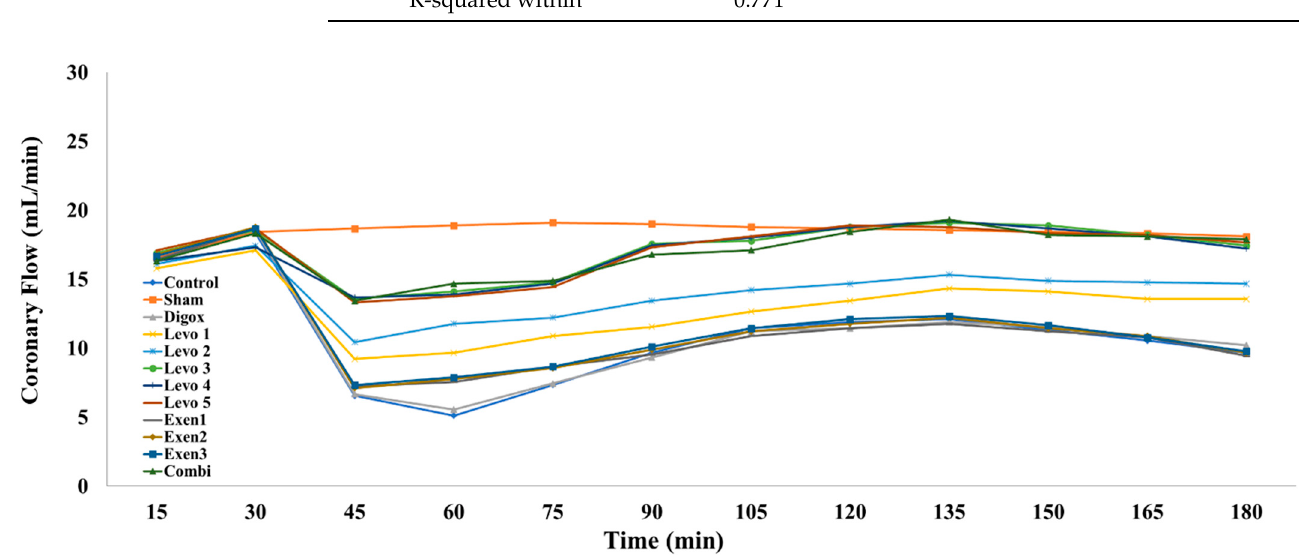
Figure 10. Changes in coronary flow across groups over time.